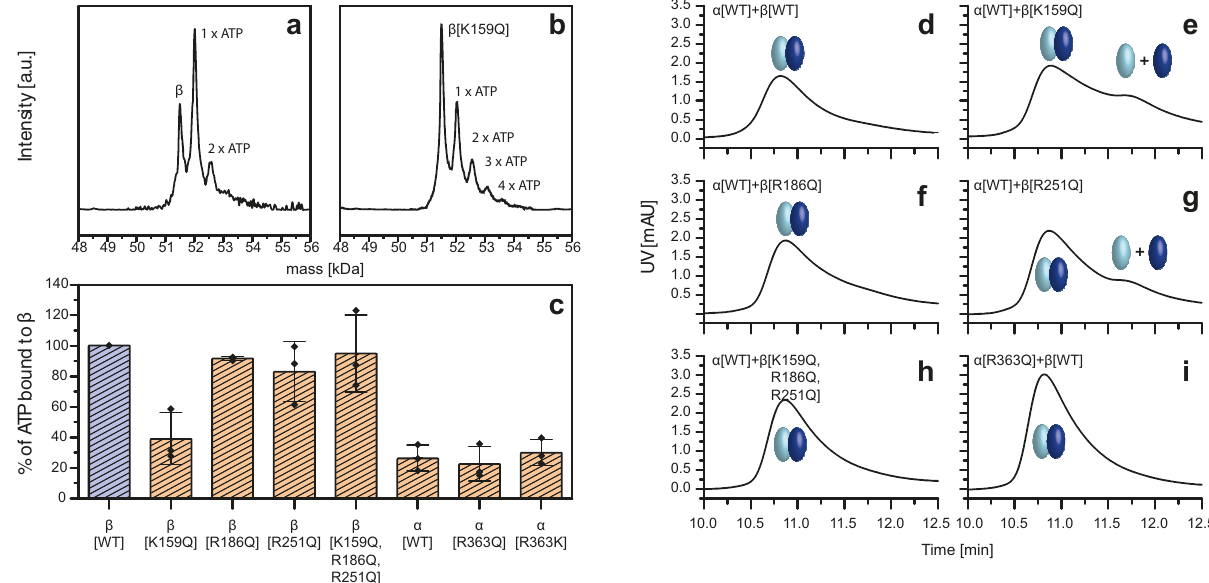
Fig. 6 Dependence of ATP-binding of α , β and their mutants and the formation of αβ heterodimers. a , b ATP-binding: deconvoluted nESI-MS spectra of ATP-binding of β [WT] ( a ) and β [K159Q] ( b ). Corresponding spectra for all α and β mutants are shown in Supplementary Fig. 4. c Summary of ATP-binding of β [K159Q], β [R186Q], β [R251Q], β [K159Q, R186Q, R251Q], α [WT], α [R363Q], and α [R363K] relative to β [WT]. Data are presented as mean values with error bars showing the SD, with individual data superimposed. d – h HPLC measurements: in vitro αβ heterodimer assembly of α [WT] (light blue) with β [WT] (dark blue) and β mutants. i HPLC measurement: In vitro αβ heterodimer assembly of β [WT] (dark blue) with α [R363Q] (light blue). Data were collected in biological replicates ( n = 3). Source data are provided as a Source Data fi